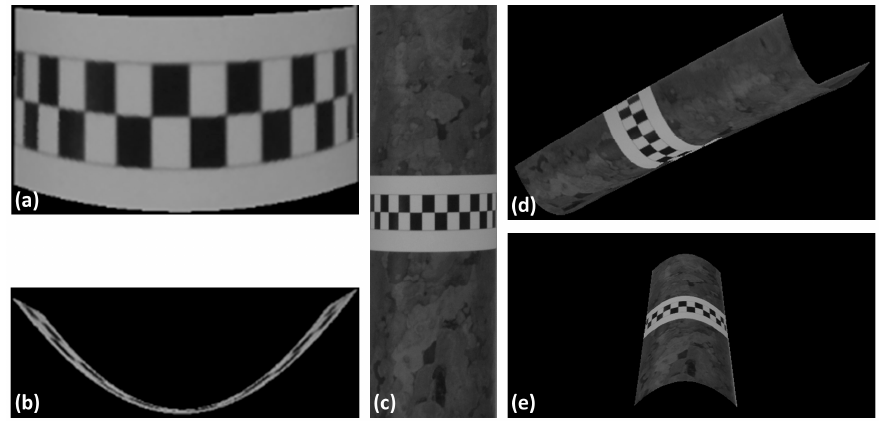
Figure 7. Continuous 3D reconstruction: ( a , b ) are two views of the reconstructed strip. ( c – e ) contains three views that show the cylinder reconstructed with its texture.